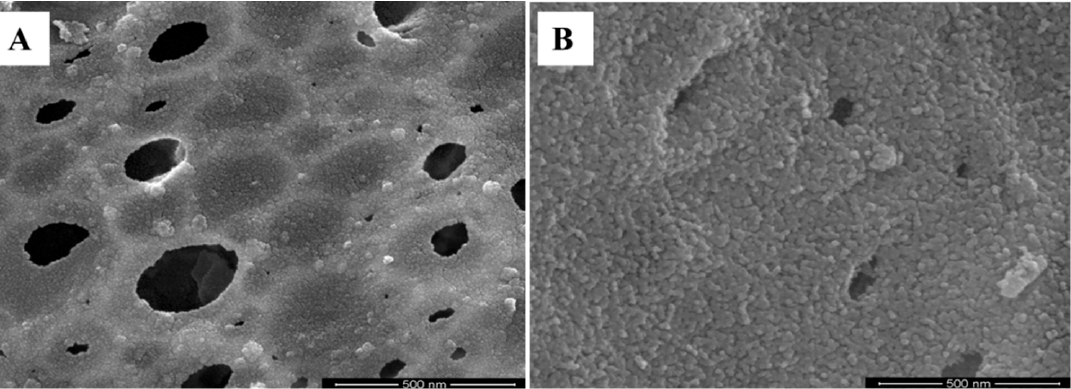
Figure 2. HR-SEM analysis of Sr-doped CoAl 2 O 4 nanoparticles, ( A ) coalescence agglomeration of nanoparticles and ( B ) aggregation of nanoparticles.